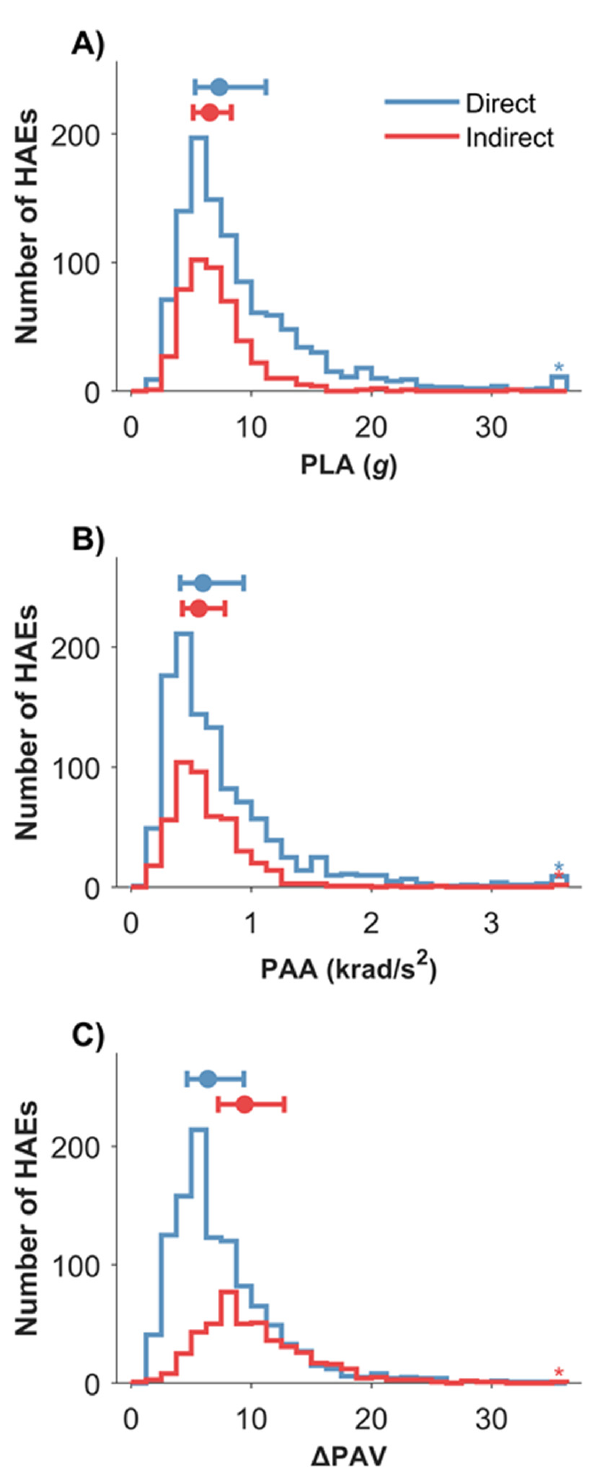
Figure 2. Distributions of direct ( n = 1108) and indirect ( n = 470) HAE, with plots showing the median and interquartile ranges for ( A ) PLA, ( B ) PAA and ( C ) ∆ PAV. Asterisks indicate HAE above ( A ) 35 g ( n = 10), ( B ) 3.5 krad/s 2 ( n = 11) and ( C ) 35 rad/s ( n = 1) which can be seen in Figure